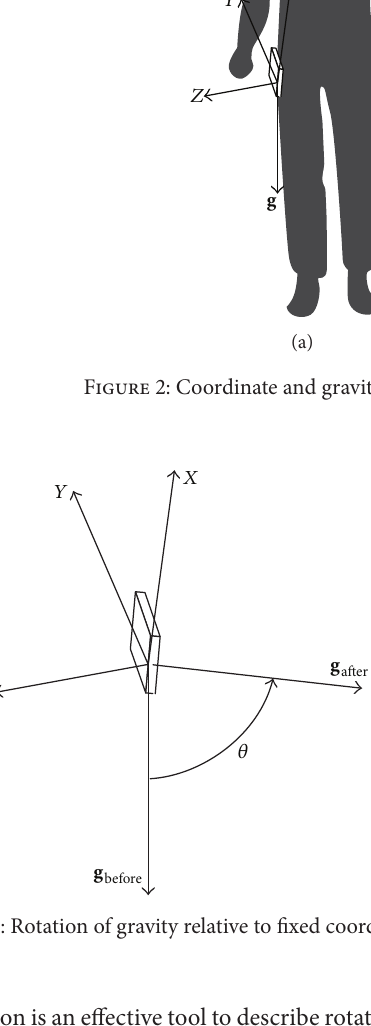
Quaternion is an effective tool to describe rotation move- ment in human’s gait change which also includes falling